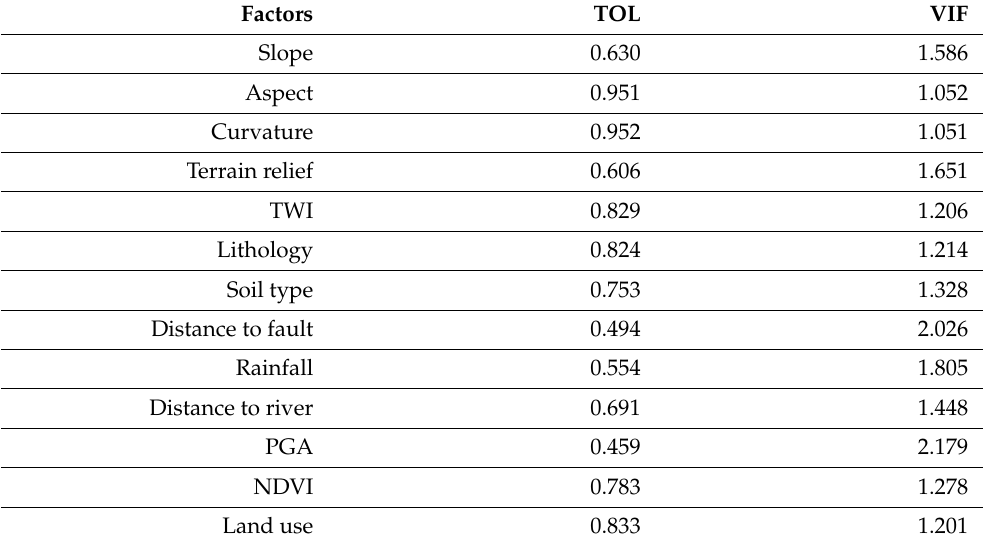
Table 5. Collinearity diagnostic results of influence